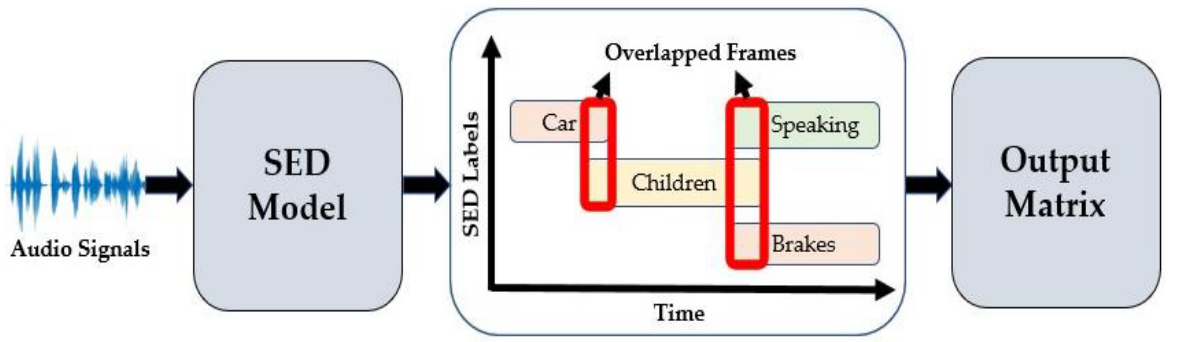
Figure 1. A general illustration of SED model .